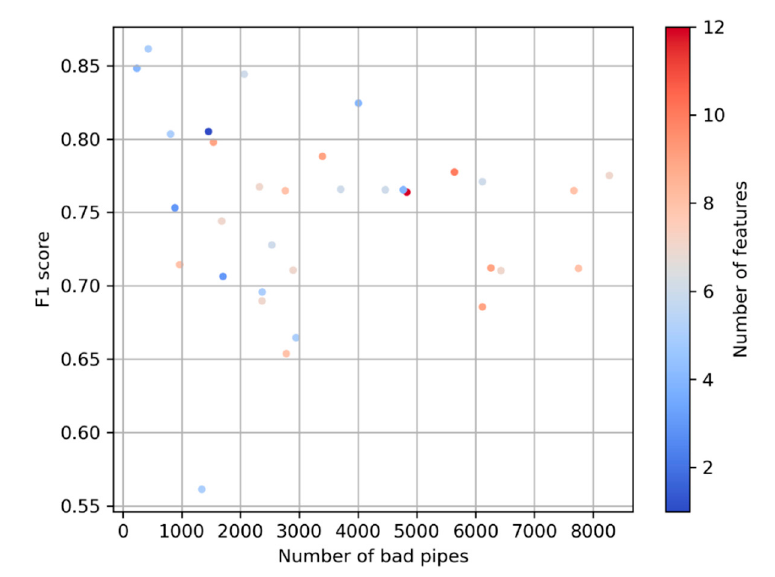
Figure 6. Plot of the relation between the number of bad pipes (first axis), the performance (second axis) and the number of relevant features.